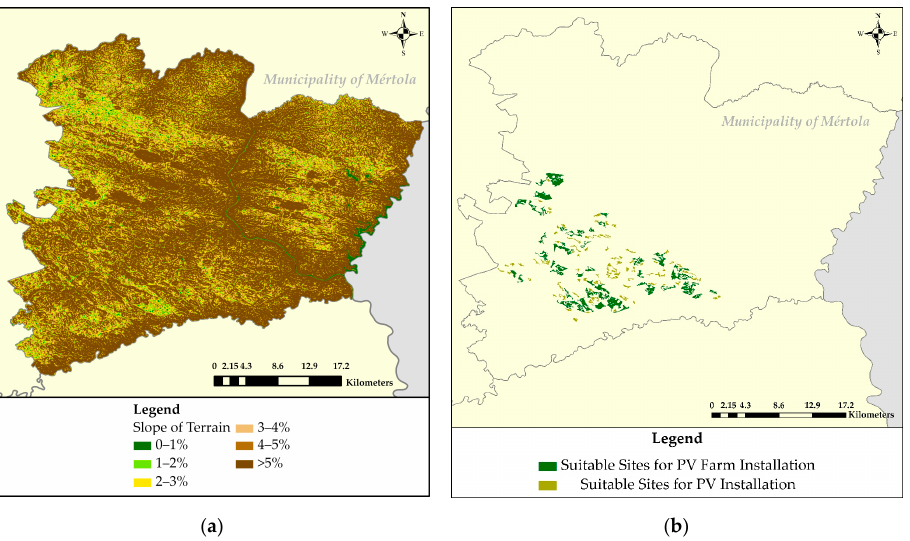
Figure 5. ( a ) Thematic map of slope of terrain (PVSC.9) and ( b ) suitable sites for PV and PV farm installation in the Municipality of Mértola.